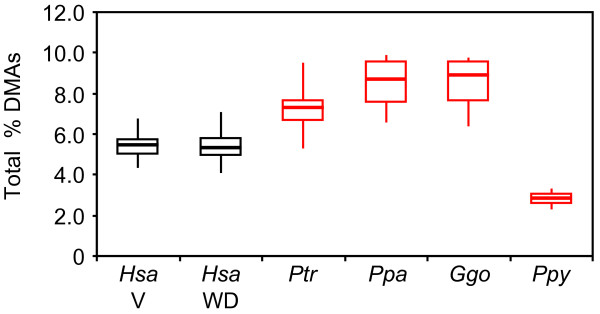
Total plasmalogen levels in human and great ape RBCs. Modified box plots representing the percentage of total plasmalogens relative to total fatty acids (Y-axis) from RBCs obtained from humans and great apes are shown. Median, quartile 1, quartile 3, minimum, and maximum values are provided. Total plasmalogens are represented as the sum of the percentage of the C16:0 DMA, C18:0 DMA, and C18:1 DMA derivatives of the chemical moieties present in the sn-1 position of plasmalogens relative to total fatty acids. The species (Hsa: human; Ptr: chimpanzee (N = 46); Ppa: bonobo (N = 4); Ggo: gorilla (N = 7); Ppy: orangutan (N = 3), human diet (V: vegan diet (N = 16), WD: western diet (N = 120) is provided on the X-axis. Animal cohort data showing a significant difference (P < 0.05) relative to both human diet groups (red), vegans alone (green), or Western diet alone (blue) are color-coded as indicated.